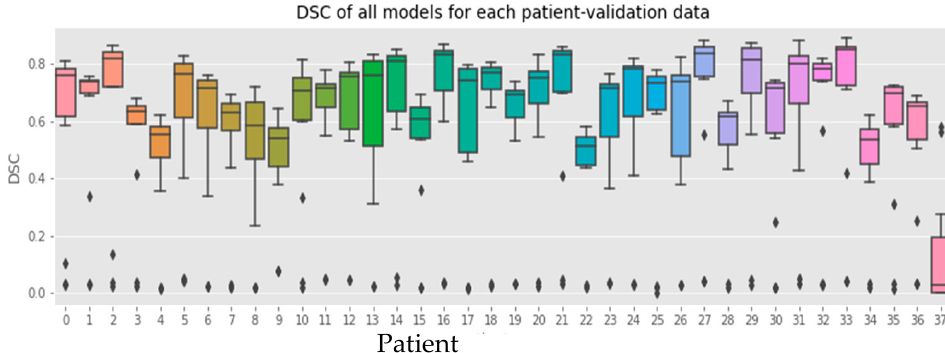
Figure 7. Box plots of Dice similarity coefficient (DSC) scores for all models for each patient in the validation data set.